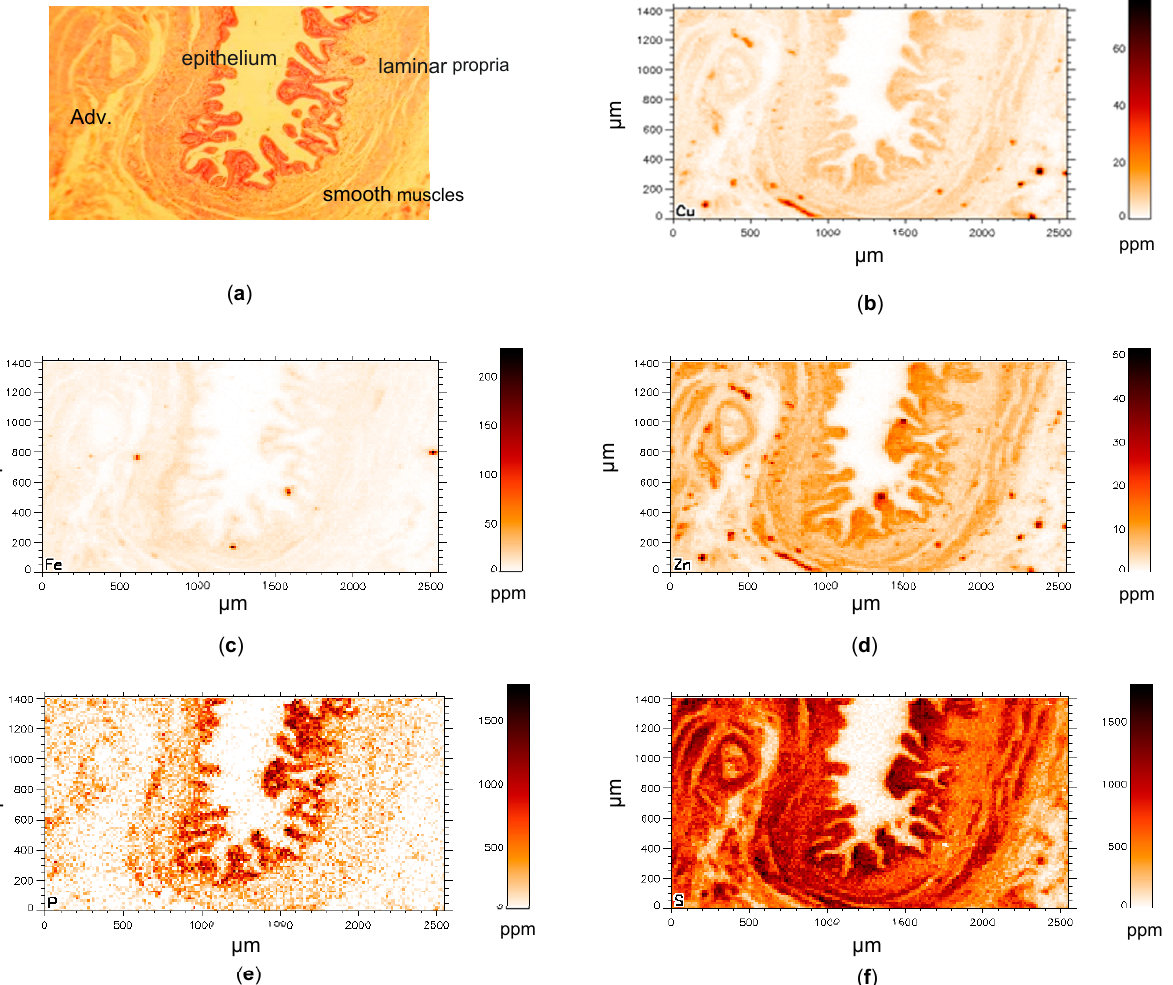
Figure 2. ( a – f ) Element distribution in a control gallbladder. ( a ) Microscope recording of the investigated gallbladder tissue with epithelium (columnar cells), beneath the epithelium the laminar propria (connective tissue) and smooth muscular fibres for contraction. Adventitia (Adv): perimuscular connective tissue that is very dense and connects with the liver. ( b – f ) copper (Cu), iron (Fe), zinc (Zn), phosphorous (P) and sulphur (S) distribution. The histological section is about 30- µ m apart from the investigated one for